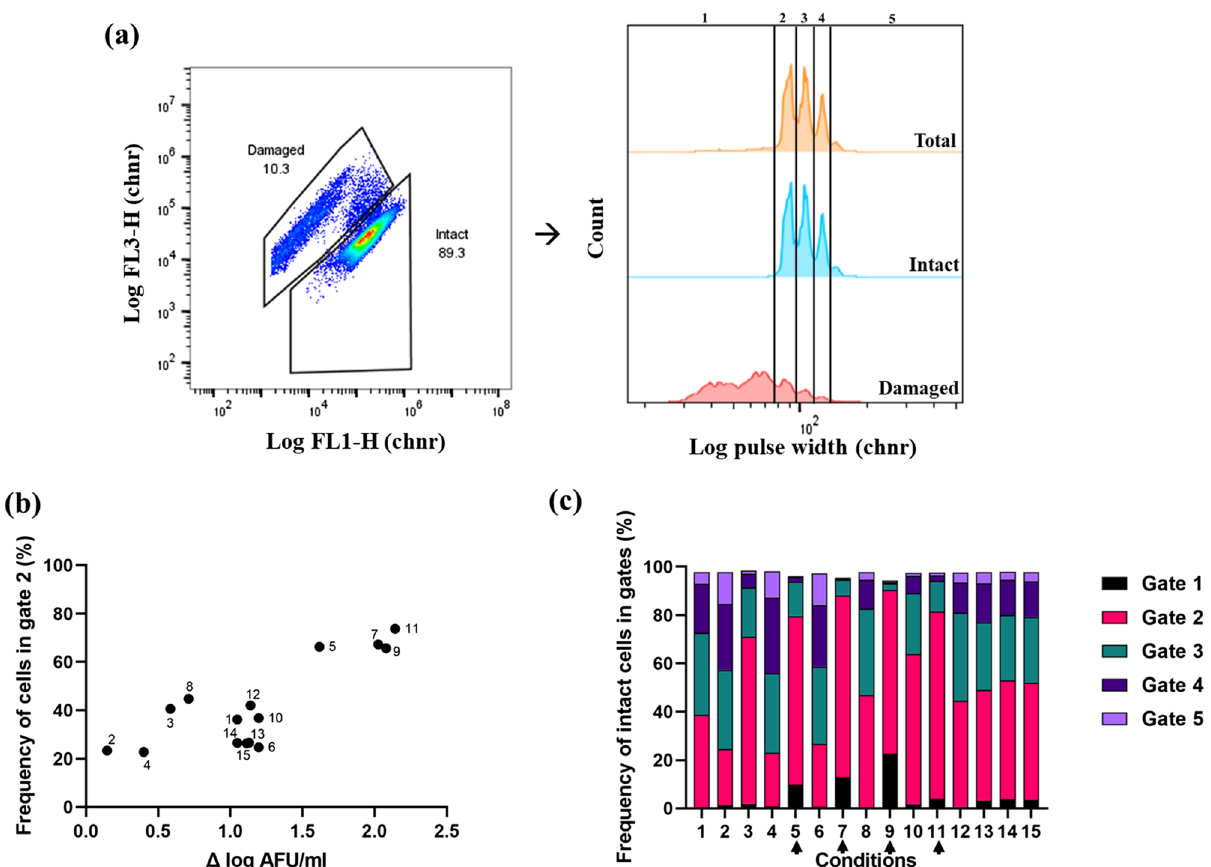
Figure 4. Pulse width distribution. ( a ) Representation of pulse width distribution and gating strategy to quantify frequency of cells in gates 1–5 for condition 6. Gates were defined using the built-in function in the FlowJo software Create Gates on Peaks (Supplementary Material, Fig. S4-2). The black lines indicate the different gates. ( b ) Correlation between frequency of cells in gate 2 (%), and growth (Δ log AFU/ml). ( c ) Distribution of intact cells in gates 1–5 based on pulse width peaks for conditions 1–15. Black arrow indicates the conditions with high Δ log AFU/ml.